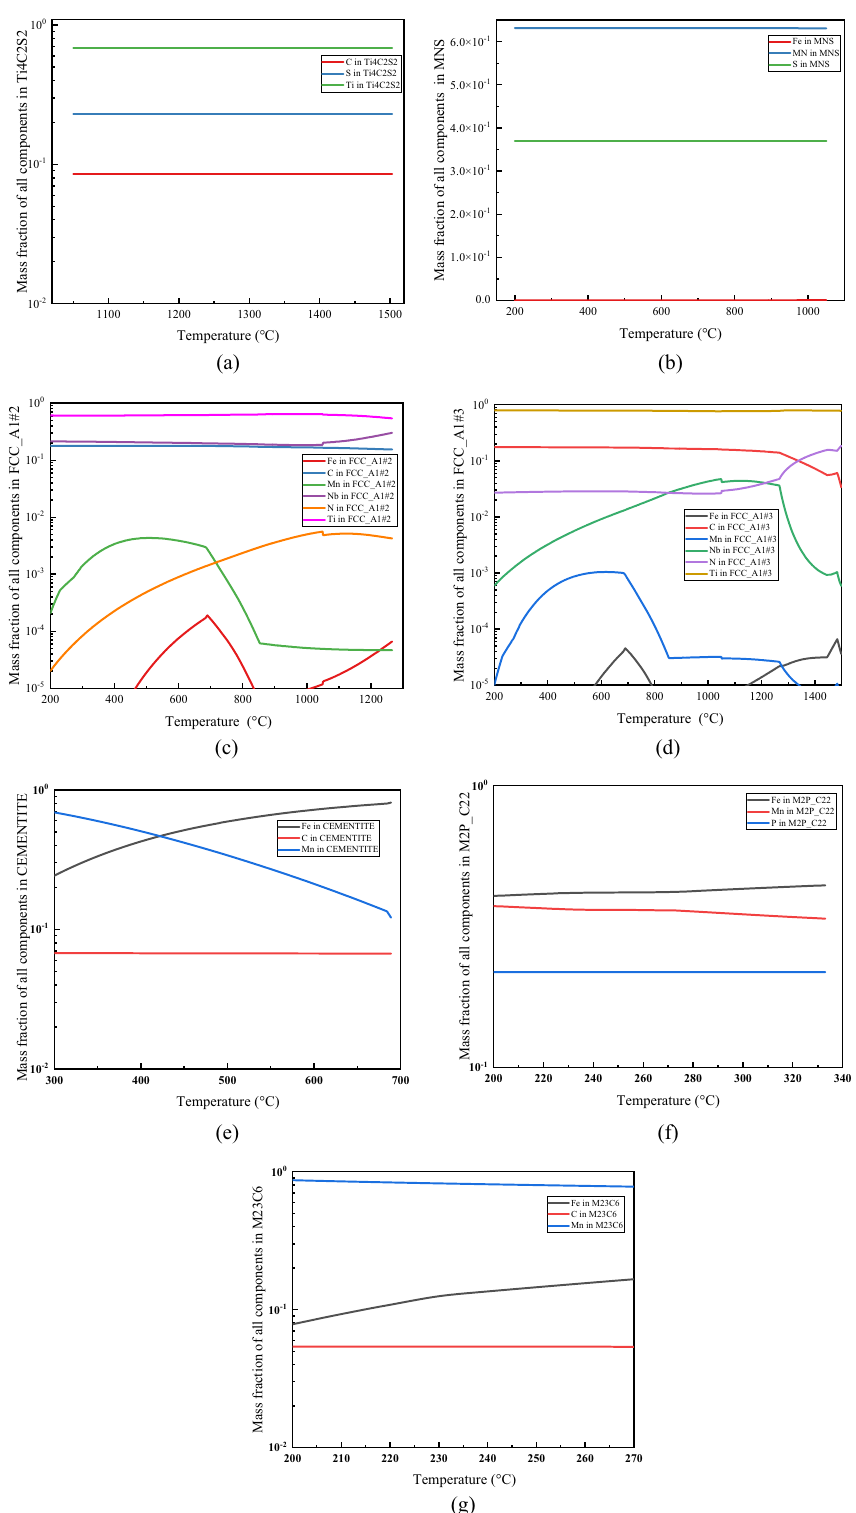
Figure 3: The relation between the composition ratio of each precipitated phase and temperature in experimental steel: ( a ) Ti 4 C 2 S 2 , ( b ) MnS, ( c ) FCC_A1#2, ( d ) FCC_A1#3, ( e ) cementite, ( f ) M